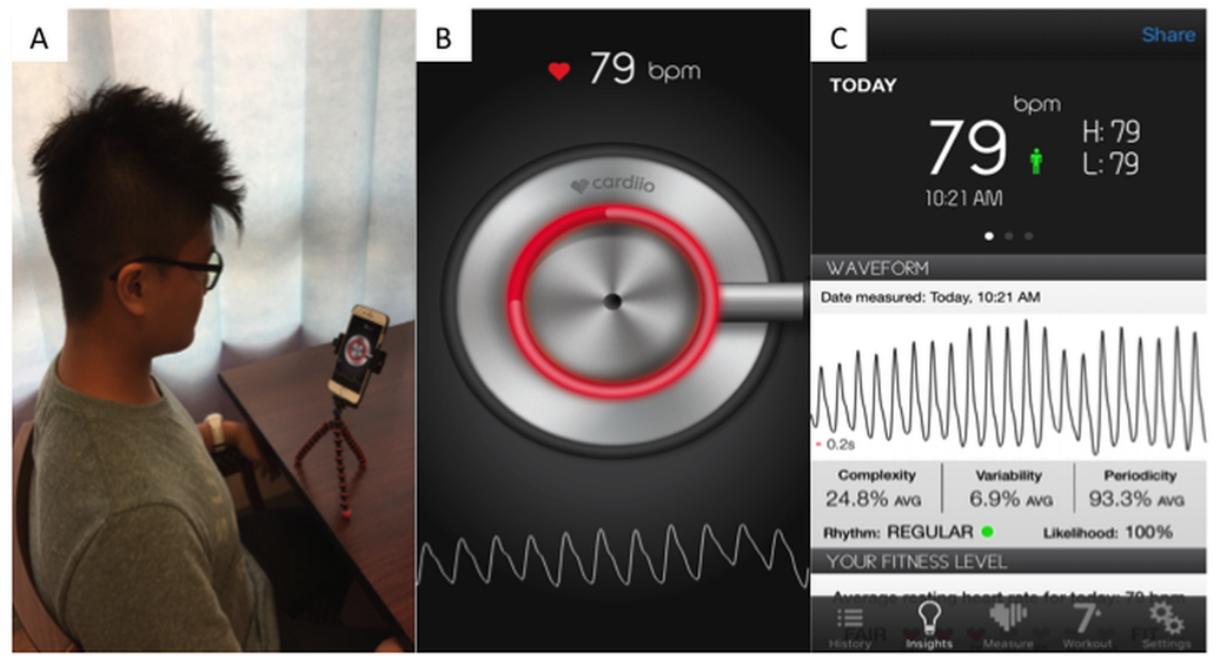
Figure 1. (A) Patient setup; (B) cardiioRhythm app facial photoplethysmography analysis interface; and (C) complete facial photoplethysmography signals